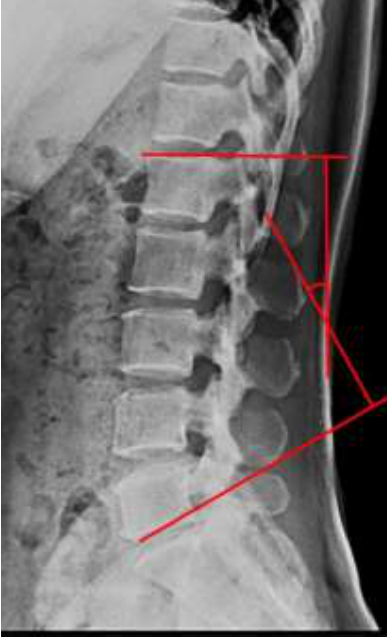
Figure 1. X-ray measurement of the lumbar lordosis angle ( Cobb’s method).